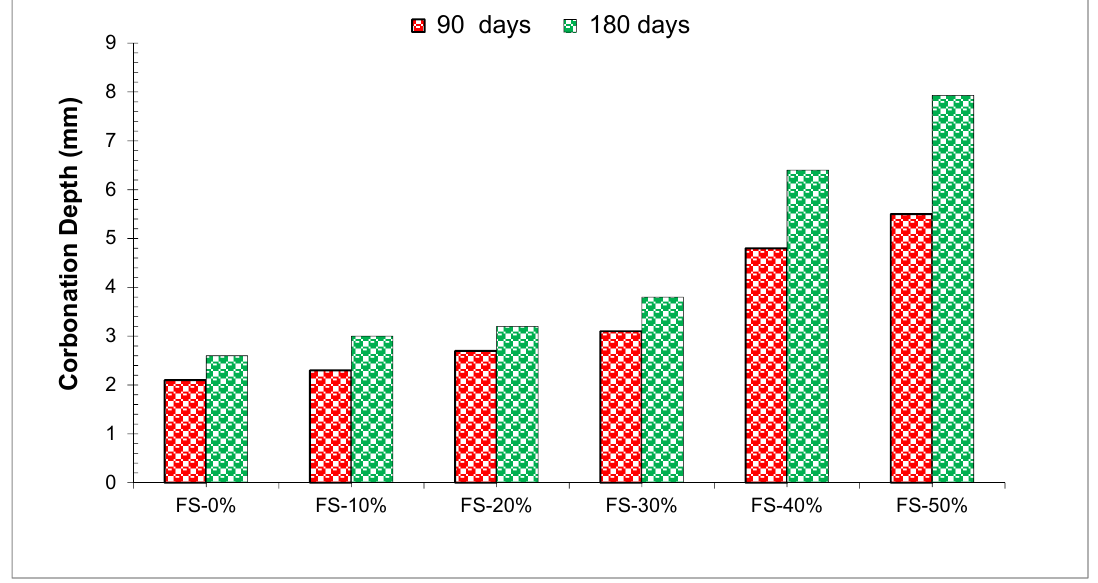
Figure 11. Carbonation Depth Test Results [39].